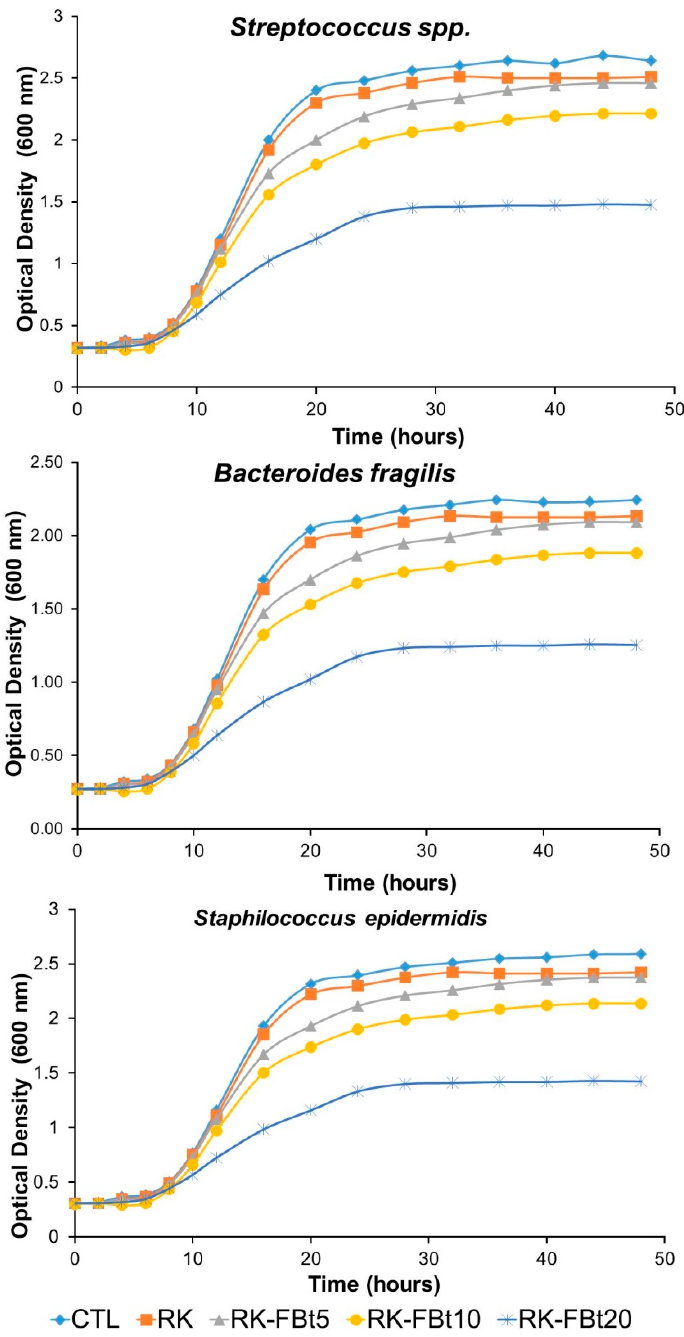
Figure 12. Antibacterial activity evaluated by DCT against Streptococcus spp., Bacteroides fragilis , and Staphylococcus epidermidis of RK, RK-FBt5, RK-FBt10, and RK-FBt20. Single bacterial strain growth in absence of composite resins was used as control (CTL). Each point on the growth curves is the average of optical density measurements in 6 wells at any given time point.